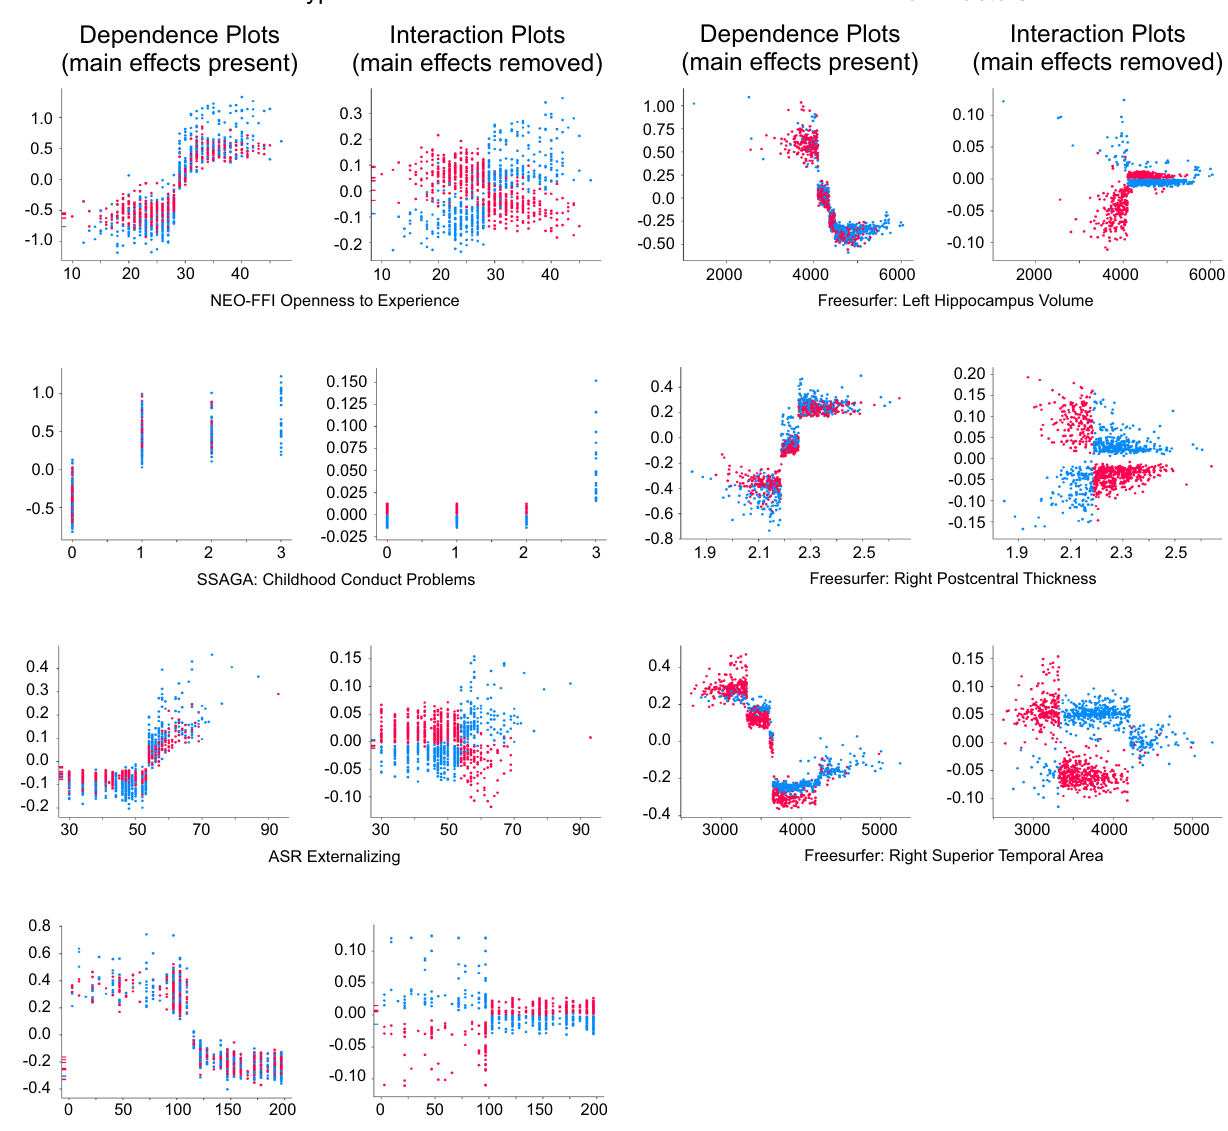
Figure 3. Several factors in the phenotypic + Freesurfer model classifying cannabis dependence showed sex/ gender interaction effects. As in previous figures, each dot indicates an individual. Dots are colored according to sex/gender (red = women, blue = men). The left columns (“Dependence plots”) show individuals colored according to sex/gender, with main effects intact; the right columns (“Interaction plots”) again show the same individuals, but with main effects removed for improved visualization of the sex/gender interaction effects. The x-axis of the plots indicates the observed measurement value of each factor, and the y-axis of each plot indicates the SHAP value (where a higher SHAP value pushed the model closer towards dependence, and lower values pushed the model away from dependence). The magnitude of the SHAP values are standardized in the model and can therefore be interpreted as effect